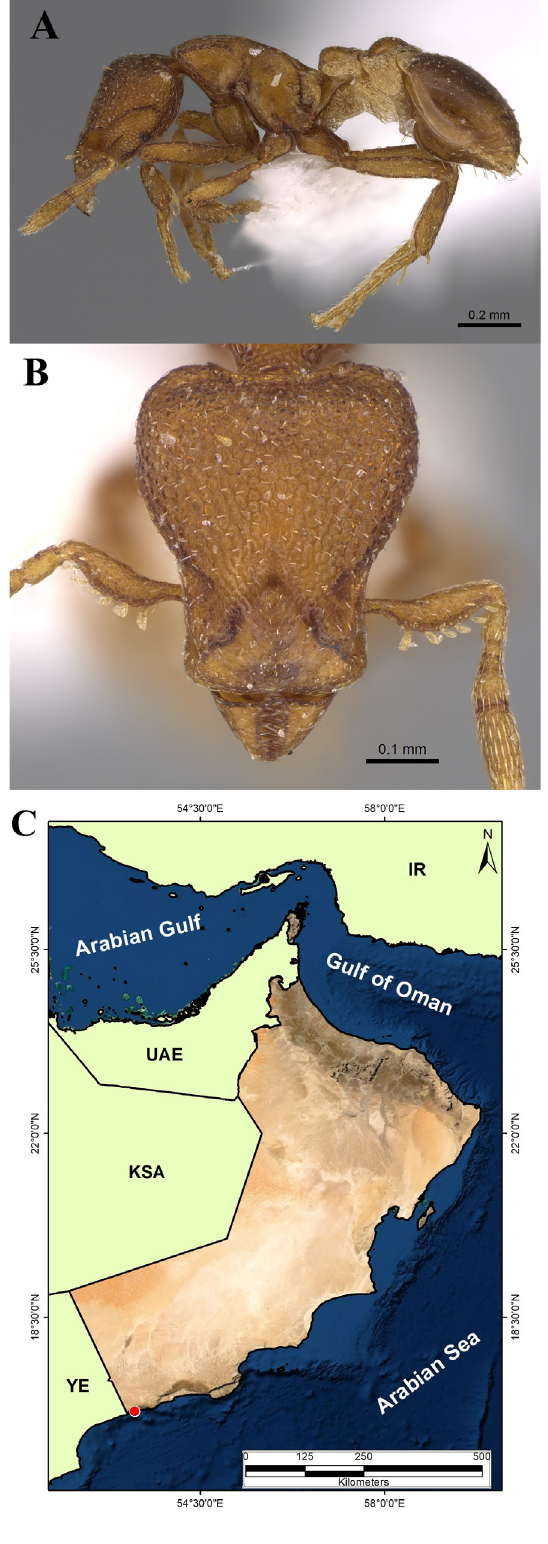
Fig. 47. Strumigenys membranifera Emery, 1869, worker (CASENT0922883, AntWeb.org (Michele Esposito)). A . Body in profile. B . Head in full-face view. C . Distribution